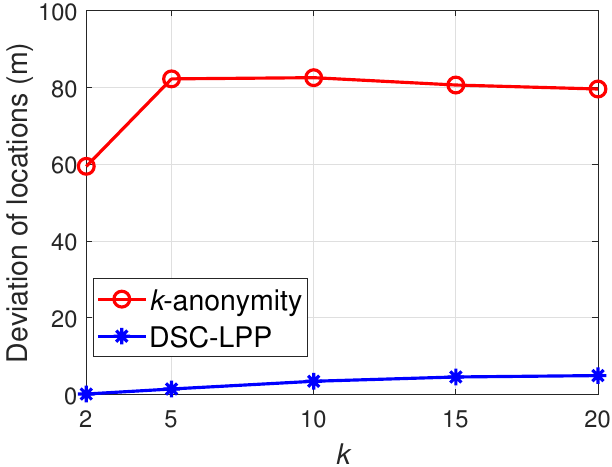
Figure 11. Average deviation of retrieved